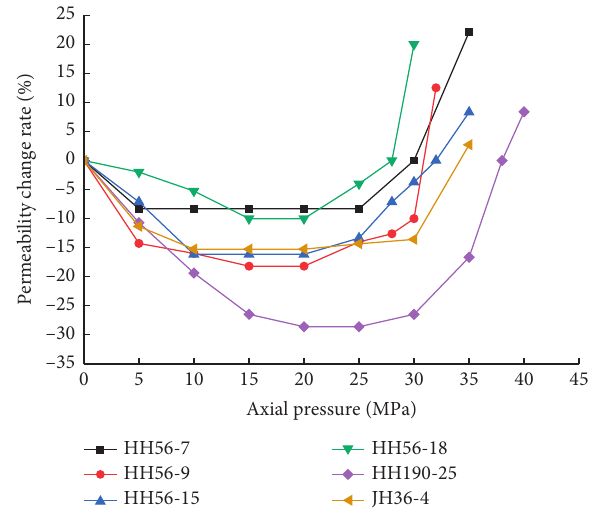
Figure 3: Permeability change rate with axial pressure